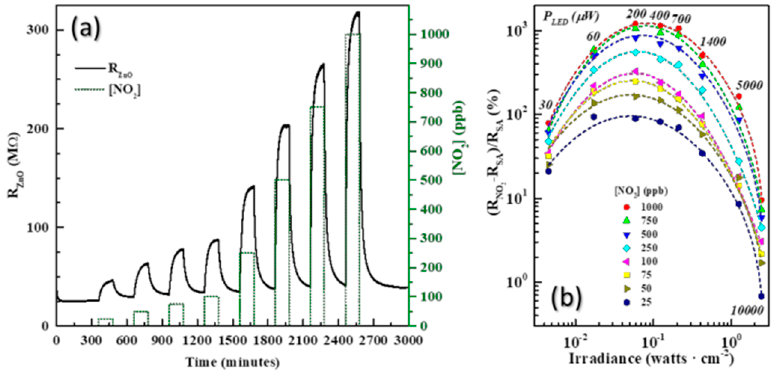
Figure 2. ( a ) Resistance record of the response to NO 2 and ( b ) summary of the responses obtained under different irradiance levels (and thus power consumption). Electrical power applied to the LED at each irradiance level is indicated in italics labels. Lines corresponds to qualitative fittings to existing models in the literature [6]. Data taken from Ref.